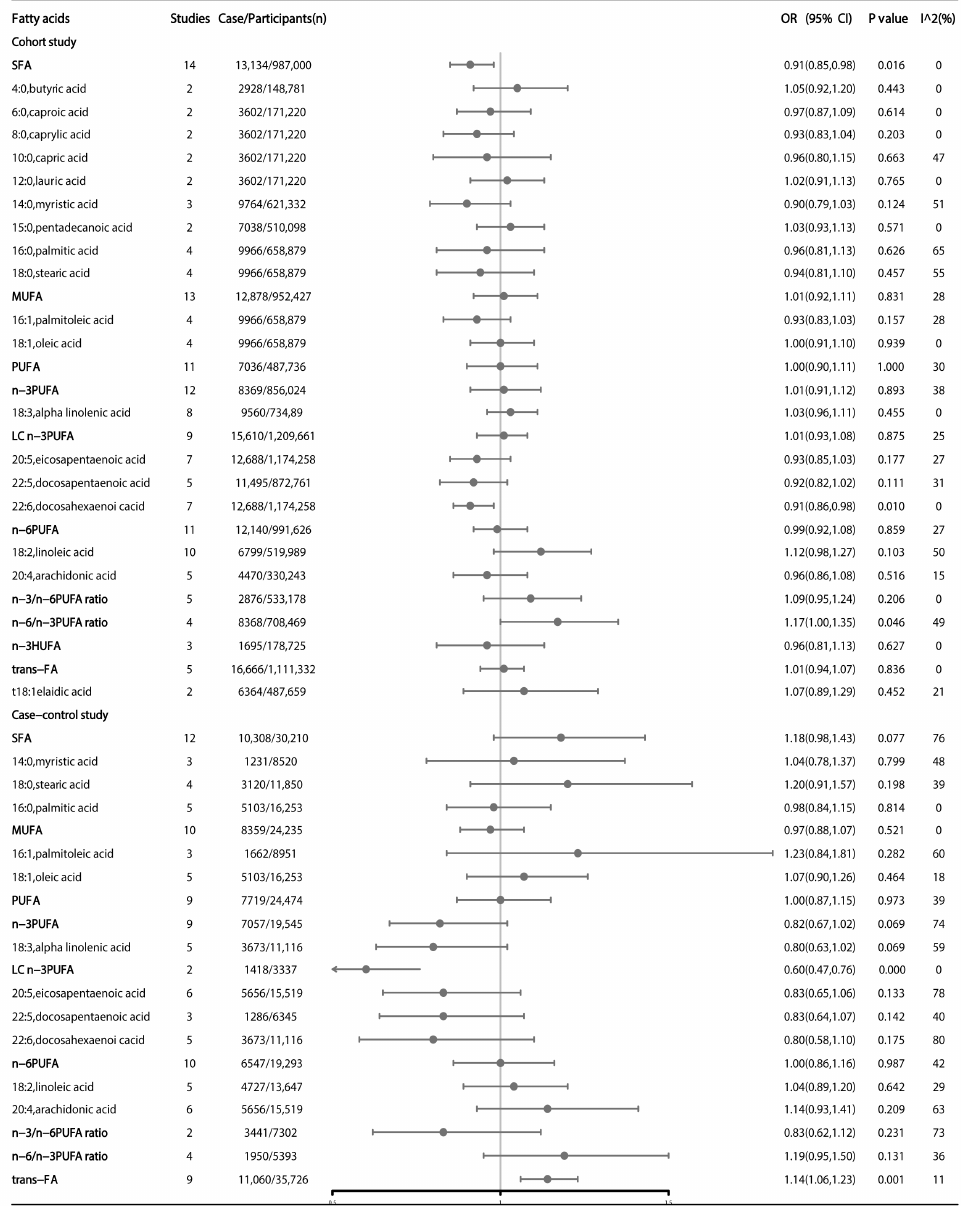
Figure 3. Subgroup analysis of dietary fatty acids and colorectal cancer by the study design. Estimates are odds ratio and meta-analyses are based on random effect models. SFA: saturated fatty acids; MUFA: monounsaturated fatty acids; PUFA: polyunsaturated fatty acids; HUFA: highly unsaturated fatty acids; trans-FA: trans-fatty acids; LC n -3 fatty acids: long-chain n -3 fatty acids.